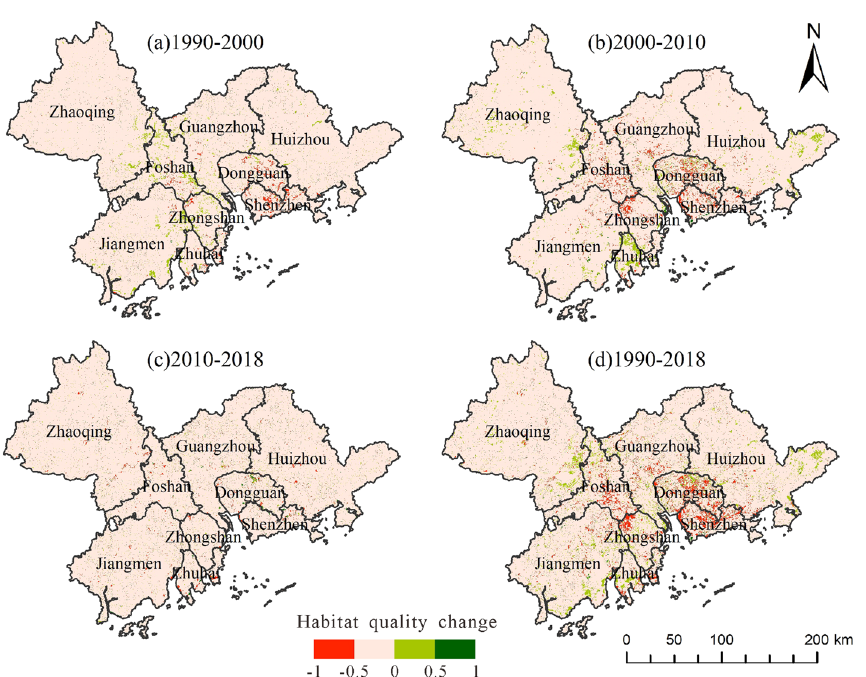
Figure 6. Spatial and temporal variation in habitat